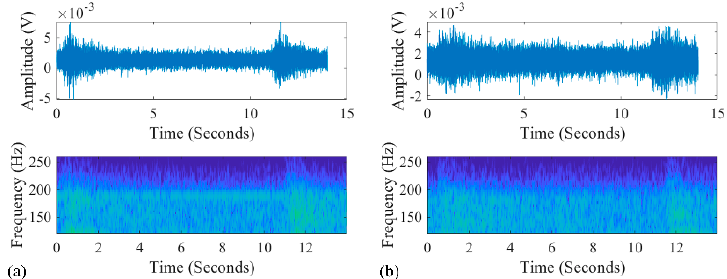
Figure 15. The signals received on the VLA at ranges of ( a ) 3.4 km and ( b ) 4.5 km. The time series between 0 and 2 s was received from an unknown broadband source.